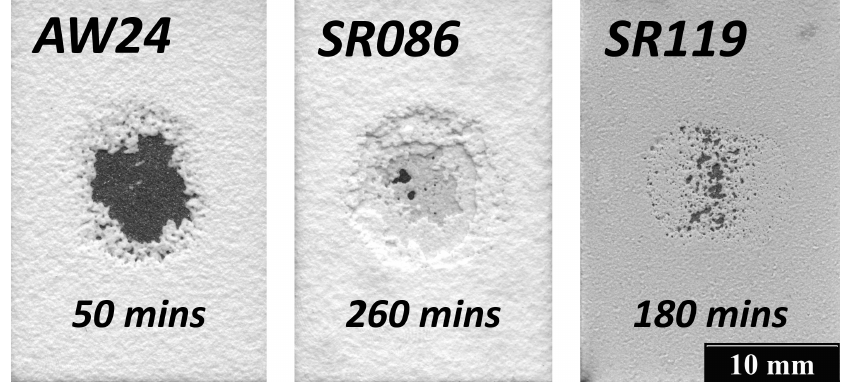
Figure 4. Eroded samples (overview) at the end of the test. Total exposure time in minutes.